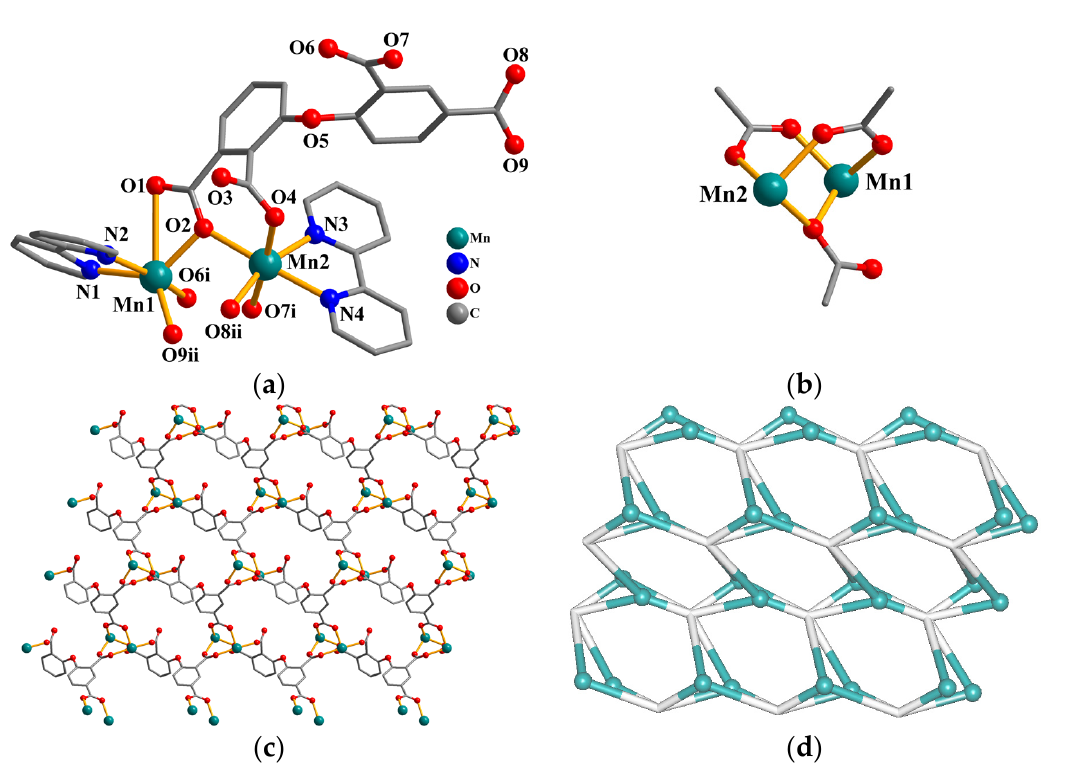
Figure 2. Structural fragments of 2 . ( a ) Coordination environment around Mn(II) atoms; H atoms are omitted for clarity. Symmetry codes: i = x + 1, y , z ; ii = x + 1, – y + 3/2, z + 1/2. ( b ) Mn 2 subunit. ( c ) 2D metal–organic layer; view along the b axis. ( d ) Topological representation of 2D layer with a 3,6L66 topology; view along the b axis; Mn(II) nodes (turquoise balls), centroids of µ 6 -dpa 4 − nodes (gray).